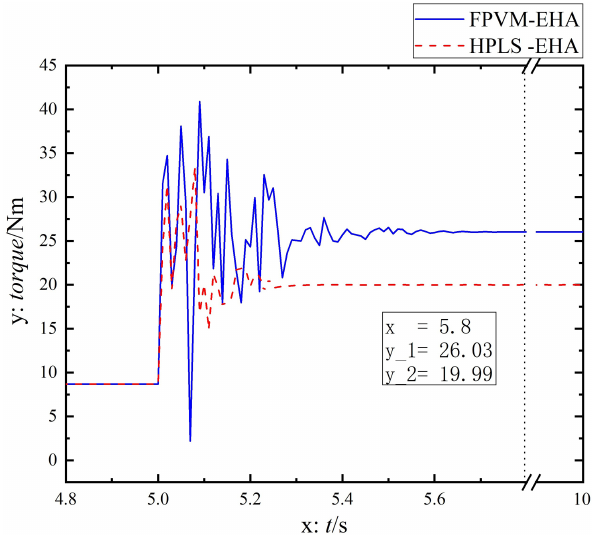
Figure 10. Contrast diagram of output position of actuator.